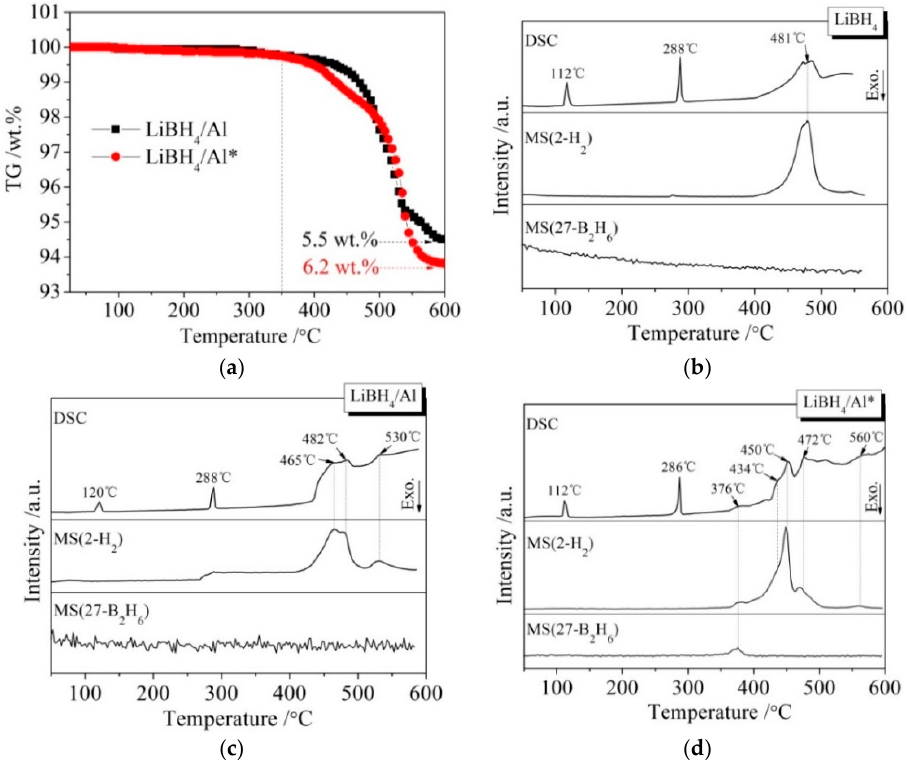
Figure 3 . Thermogravimetry (TG) curves ( a ) of LiBH 4 /Al and LiBH 4 /Al* samples and differential Figure 3. Thermogravimetry (TG) curves ( a ) of LiBH 4 / Al and LiBH 4 / Al* samples and di ff erential scanning calorimetry/mass spectrometry (DSC/MS) curves of LiBH 4 ( b ), LiBH 4 /Al ( c ), and LiBH 4 /Al* scanning calorimetry / mass spectrometry (DSC / MS) curves of LiBH 4 ( b ), LiBH 4 / Al ( c ), and LiBH 4 / Al* ( d ) samples. ( d )